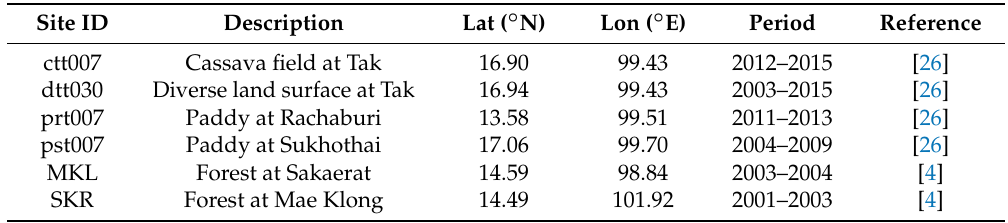
Table 2. Flux observation sites